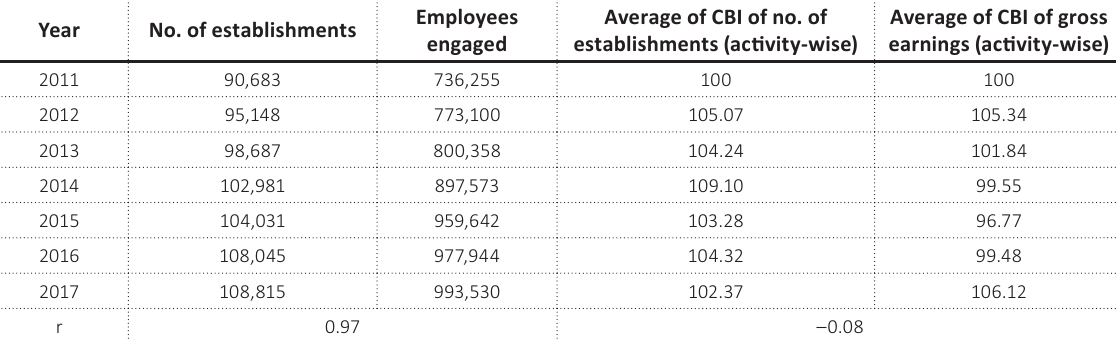
Table 3. Relationship (long-term and short-term) between the number of establishments and employees